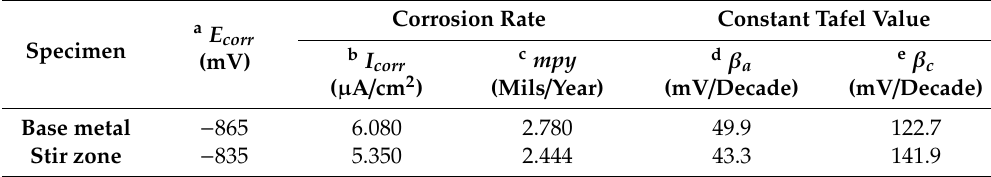
Table 2. Estimated values of the electrochemical test on the potentiodynamic anodic polarization of